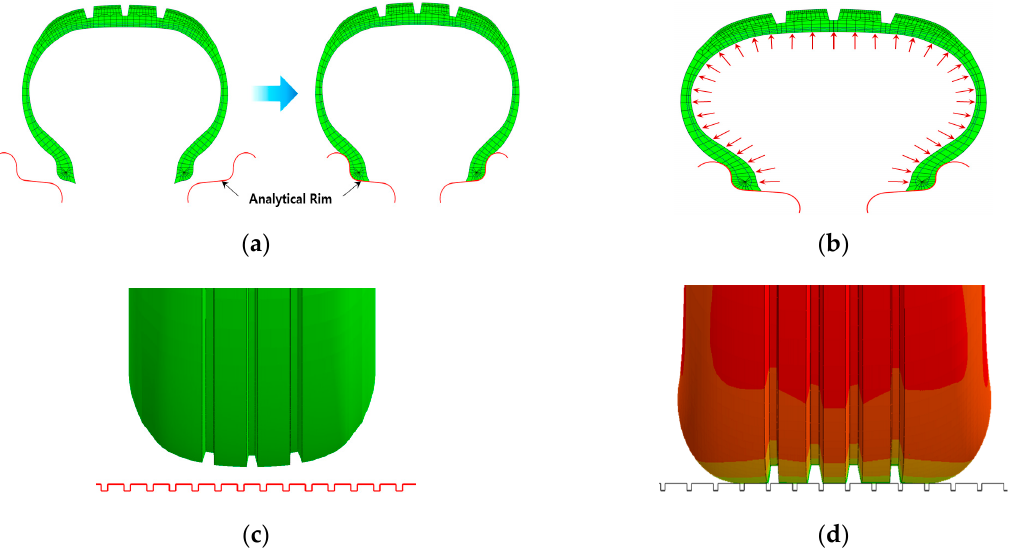
Figure 3. Steps of finite element analysis for tire-surface. ( a ) Rim Fitting. ( b ) Inflation. ( c ) Relocation of Road Surface. ( d )